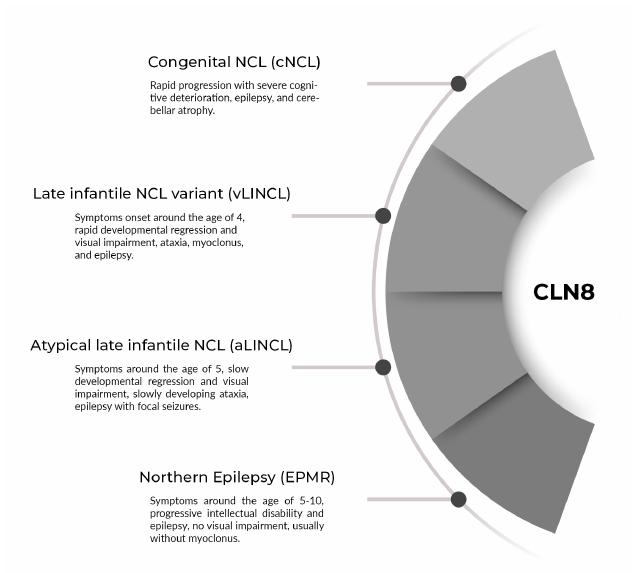
Figure 3. The proposed spectrum of NCL8 clinical